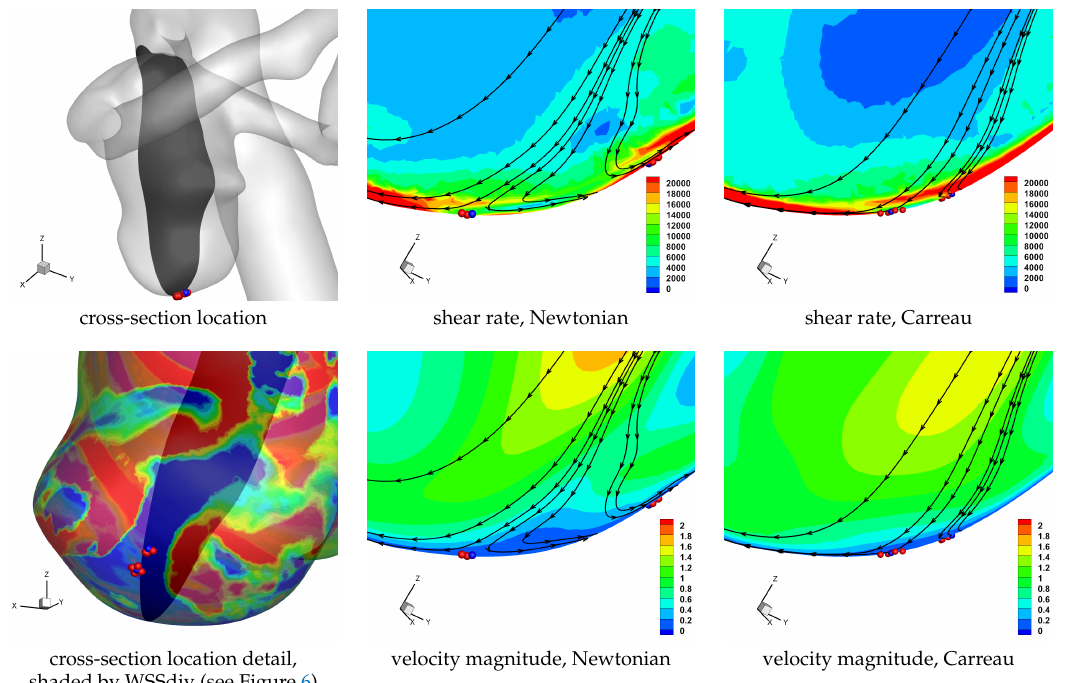
Figure 12. Detail of aneurysm dome for Case 3 at t = 0.181 s. Cross-section location and selection of unstable node critical points are shown in left column. Detail of cross-sections present a snapshot of in-plane velocity streamlines, with plots of velocity magnitude and shear rate magnitude, for Newtonian and Carreau rheological